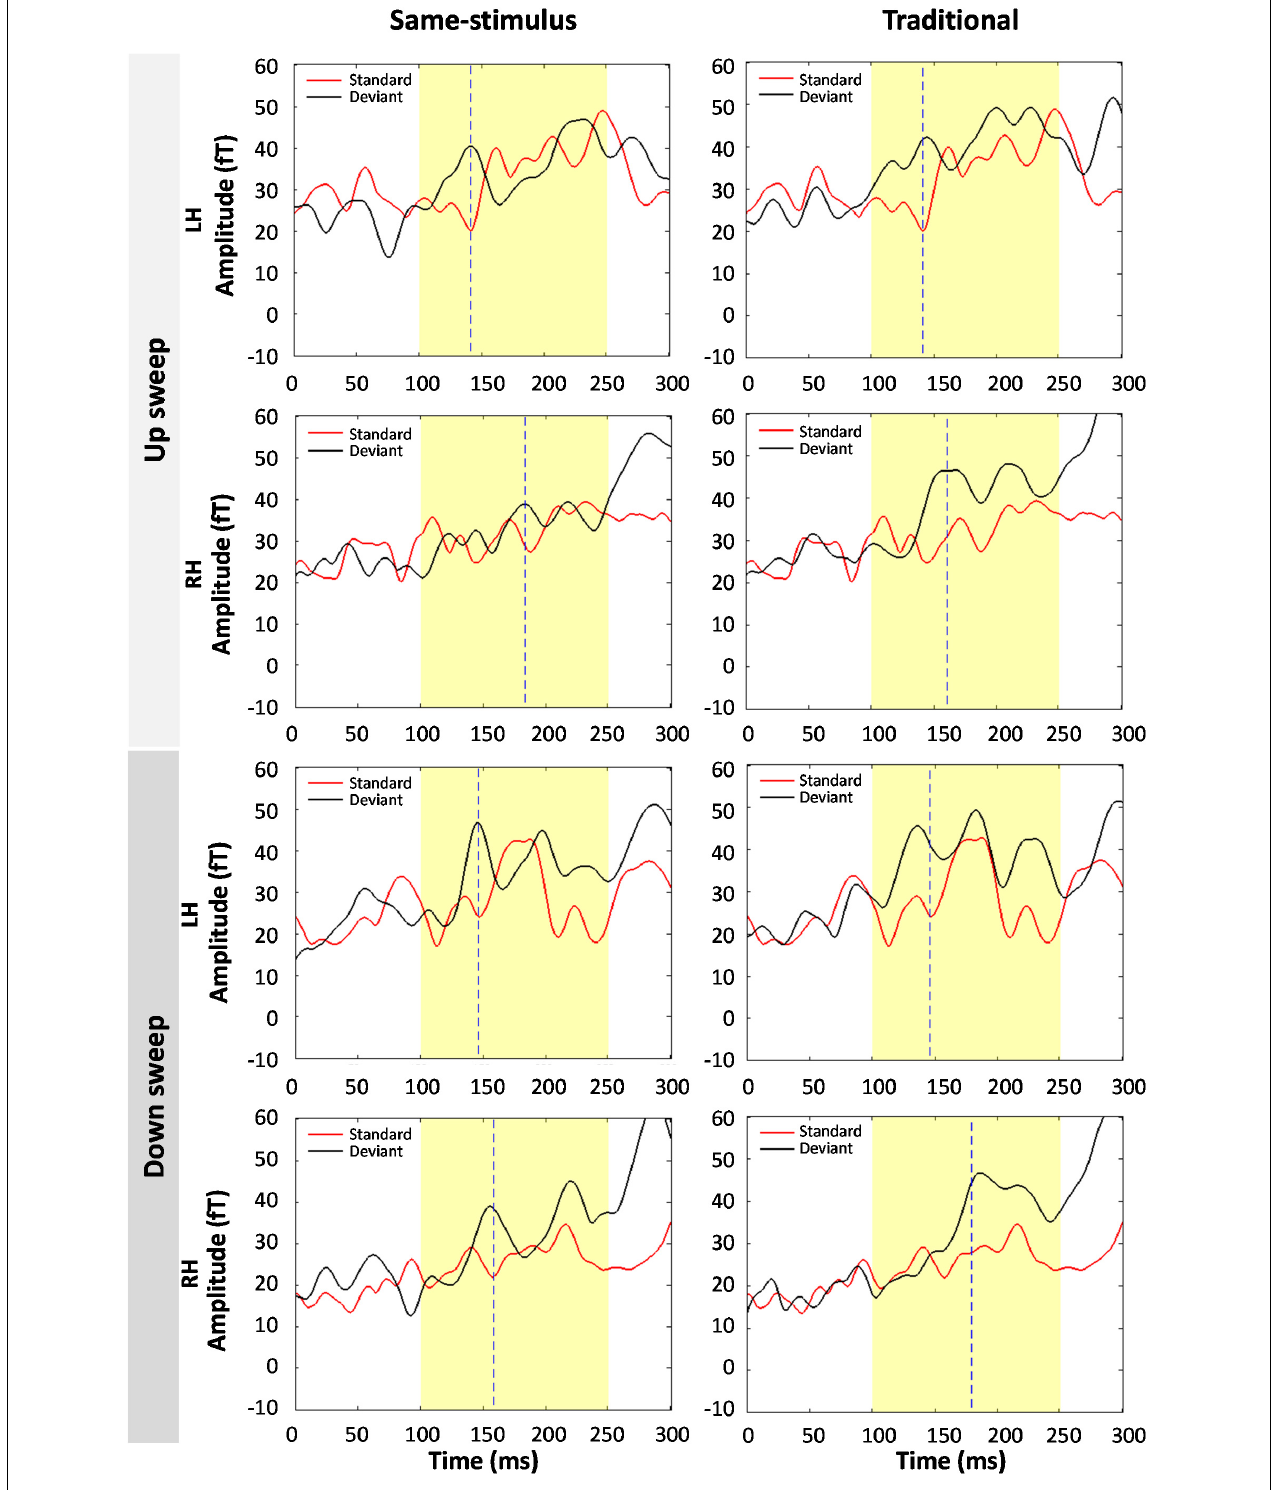
FIGURE 7 | Comparison of average standard and deviant waveforms in response to 10-ms FM sweeps using same-stimulus (left panel) and traditional calculations. (Top four panels) show the magnetic field responses to upward FM sweeps and (bottom four panels) show downward sweeps. LH and RH indicate response in the left and right hemispheres, respectively. Dashed line indicates the peak latency of the MMNm response. No significant difference in average MMNm amplitudes was observed in both same-stimulus and traditional methods.